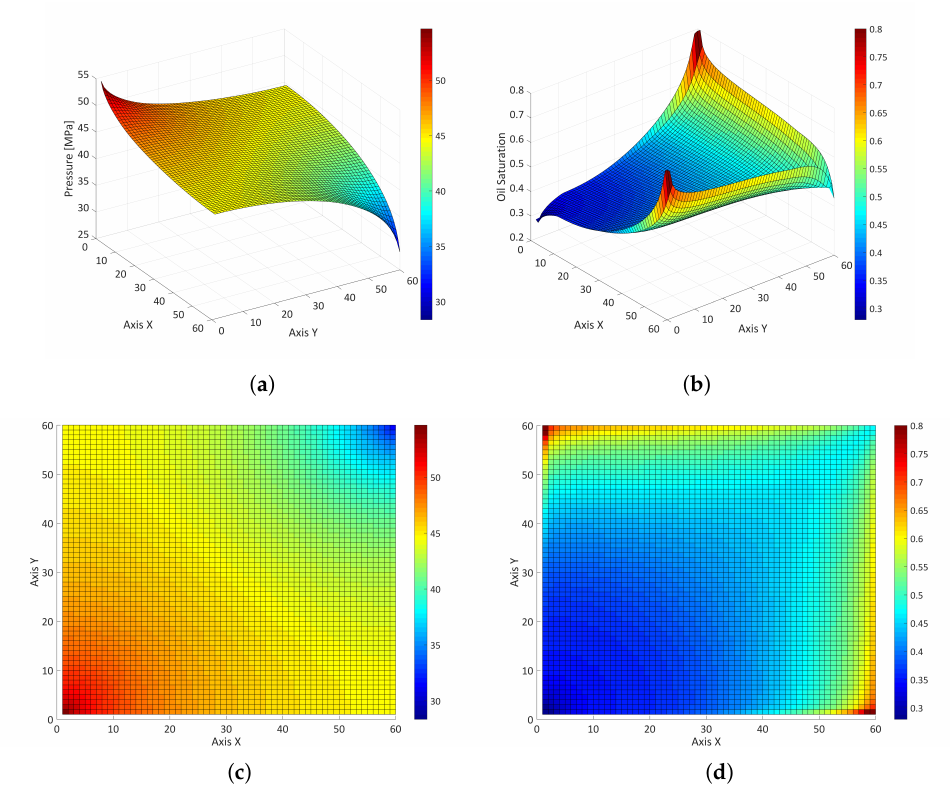
Figure 6. Pressure (in MPa) (left— a and c ) and oil saturation (right— b and d ) during the secondary recovery after 5000 days, for the model with a grid size of 60 elements.